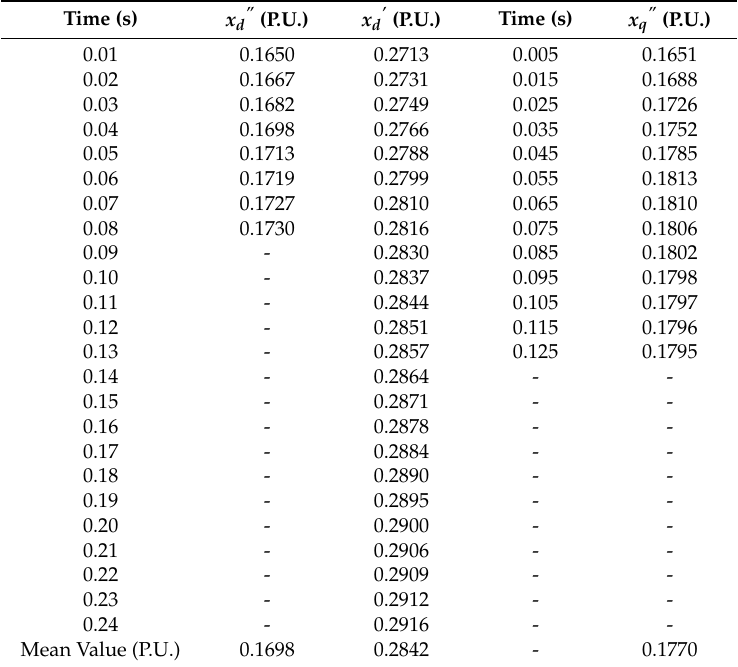
Table 3. Subtransient and transient reactance parameters values at calculation time